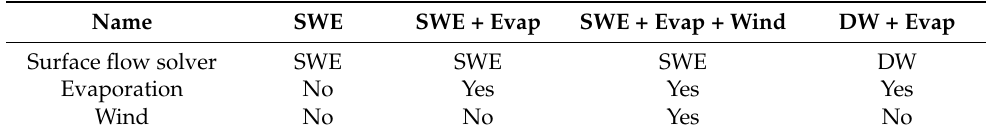
Table 6. List of the four test cases for the Trinity Delta test